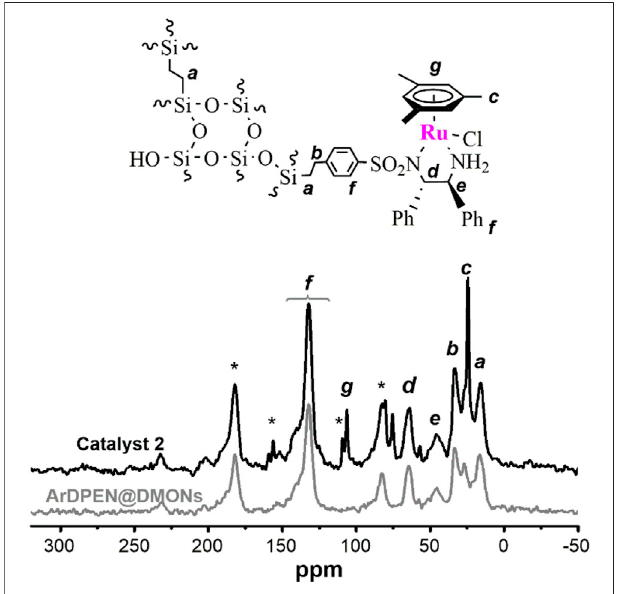
FIGURE1| Solid-state 13 CCP/MAS NMRspectraofArDPEN@DMONs and catalyst